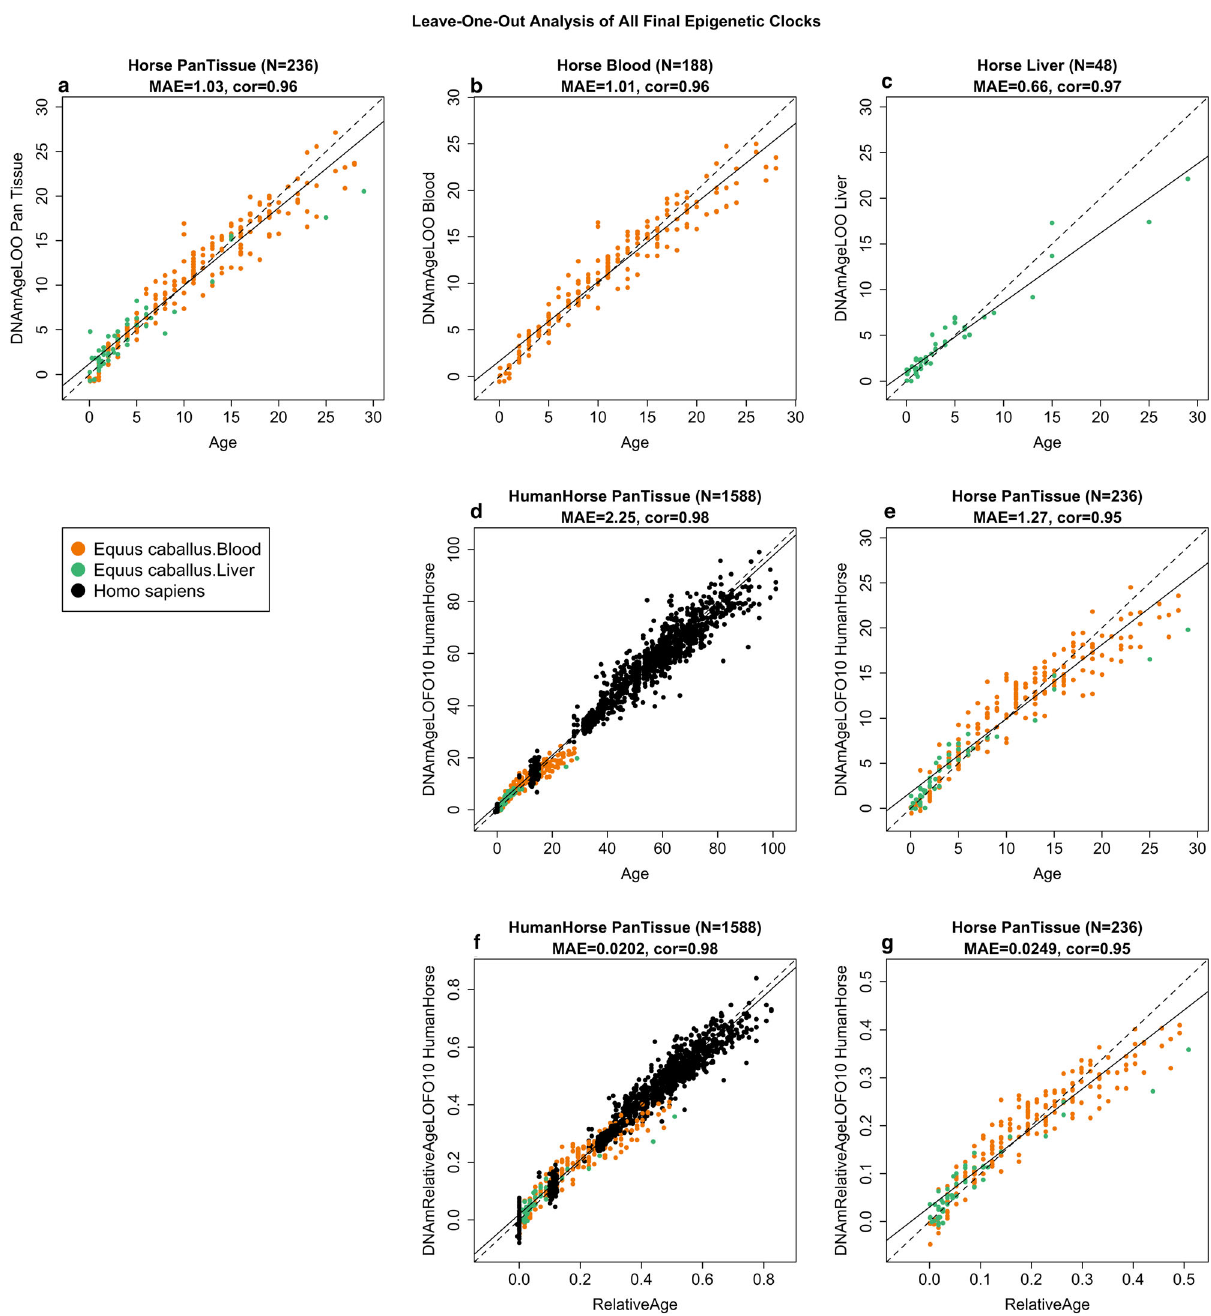
Fig. 1 Cross-validation study of epigenetic clocks for horses and humans. Chronological age ( x -axis) versus leave-one-sample-out (LOSO) estimate of DNA methylation age ( y -axis, in units of years) for a the multi-tissue clock for horse blood and liver, b horse blood clock, c horse liver clock. d Ten-fold cross-validation (LOFO10) analysis of the human-horse clock for chronological age. Dots are colored by species (black = human) and horse tissue type (green = liver, orange = blood). e Same as panel d but restricted to horses. f Ten-fold cross-validation analysis of the human – horse clock for relative age, which is the ratio of chronological age to the maximum recorded lifespan of the respective species. g The same as panel d but restricted to horses. Each panel reports sample size, correlation coef fi cient, median absolute error